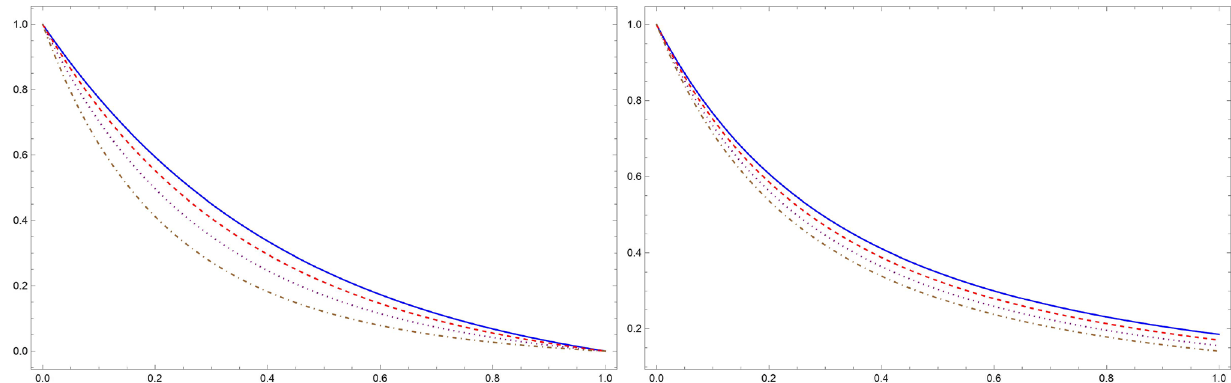
Fig. 3 ˜ P r / ˜ P rc (left) and ˜ ρ/ ˜ ρ c (right) vs x for u (cid:5) = 1 . 1 , y = 0 . 38 solid (blue) curve, y = 0 . 39 dashed (red) curve, y = 0 . 40 dotted (purple) curve and y = 0 . 41 dot-dashed (brown) curve. Second case with vanishing complexity using F-S as seed